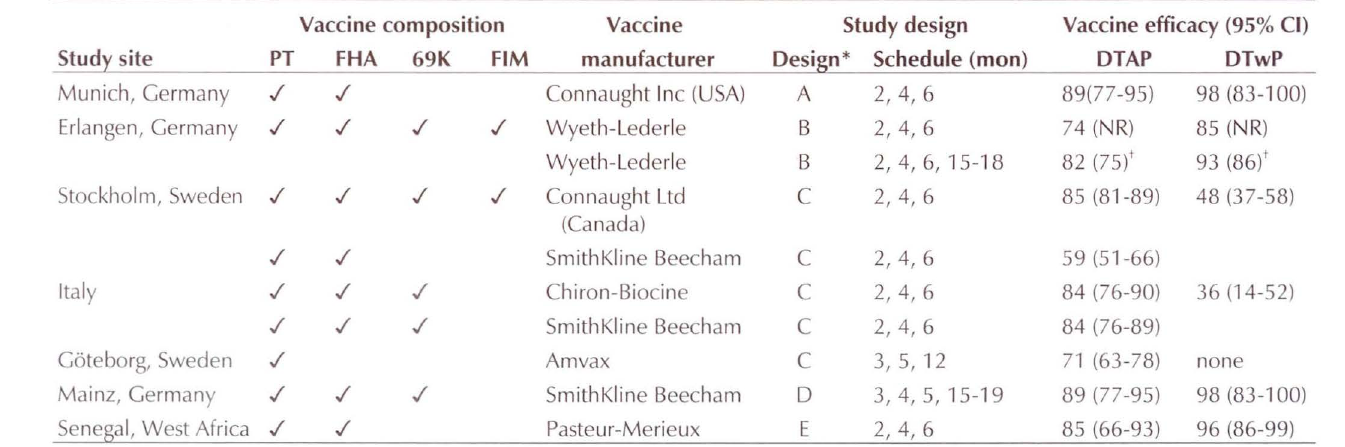
Summary of efficacy studies with acellular pertussis vaccines combined with diptheria and tenanus toxoids in infants Vaccine